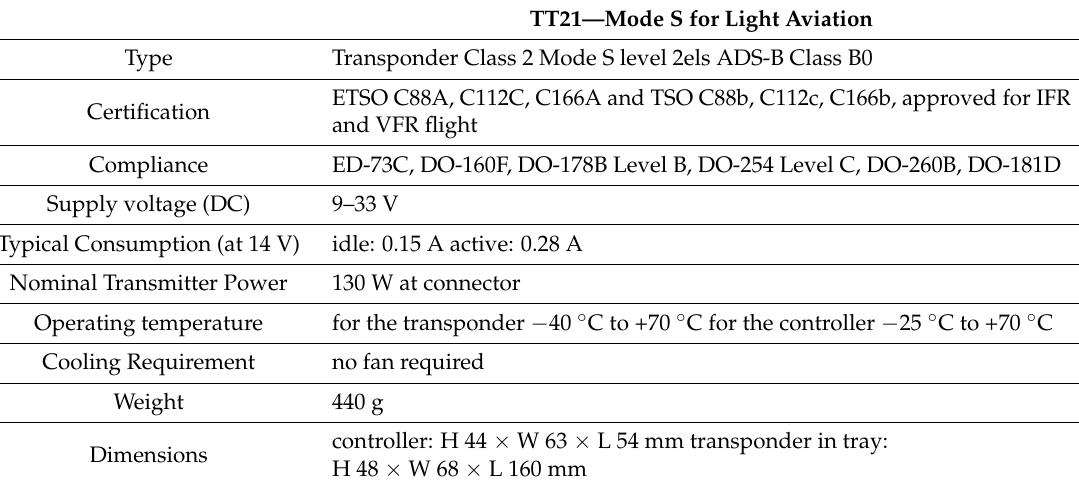
Table 3. TT21 technique